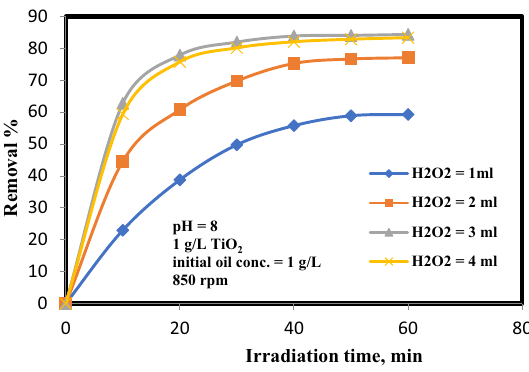
Figure 6. Influence of H 2 O 2 concentrations on oil decomposition.